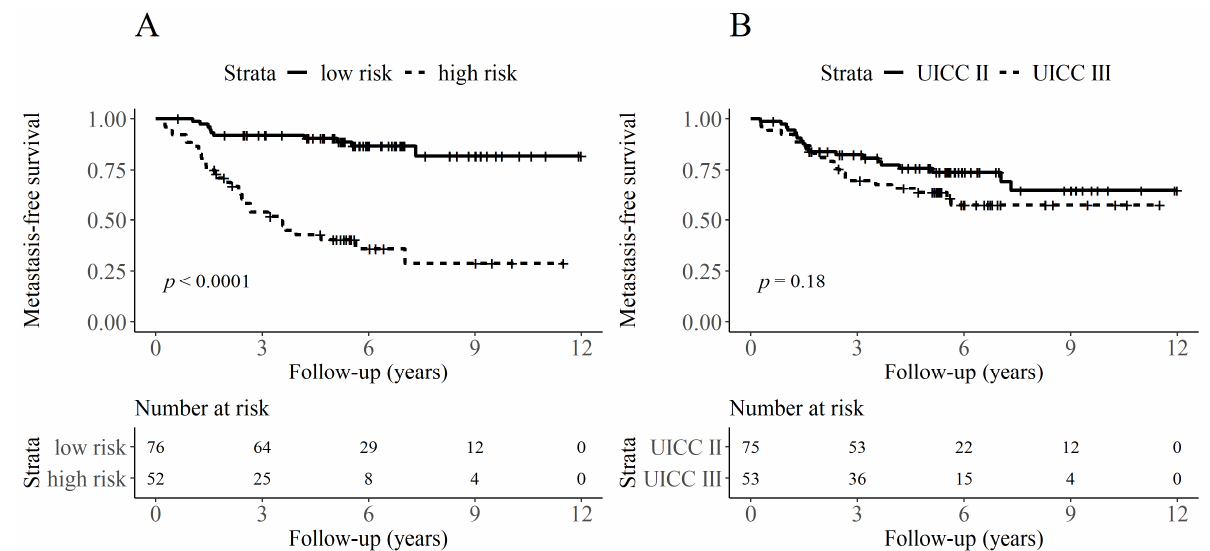
Figure 3. Kaplan-Meier curves for the occurrence of distant metastasis. Patients are stratified based on the classification of BIg-CoMet ( p < 0.0001) ( A ) and the different UICC stages ( p = 0.18) ( B ).